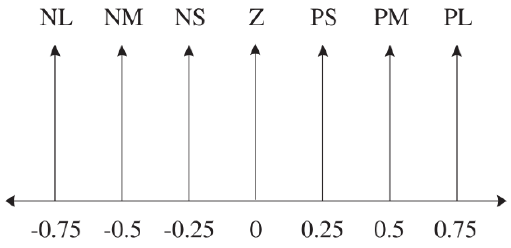
Figure 4. Output membership function.